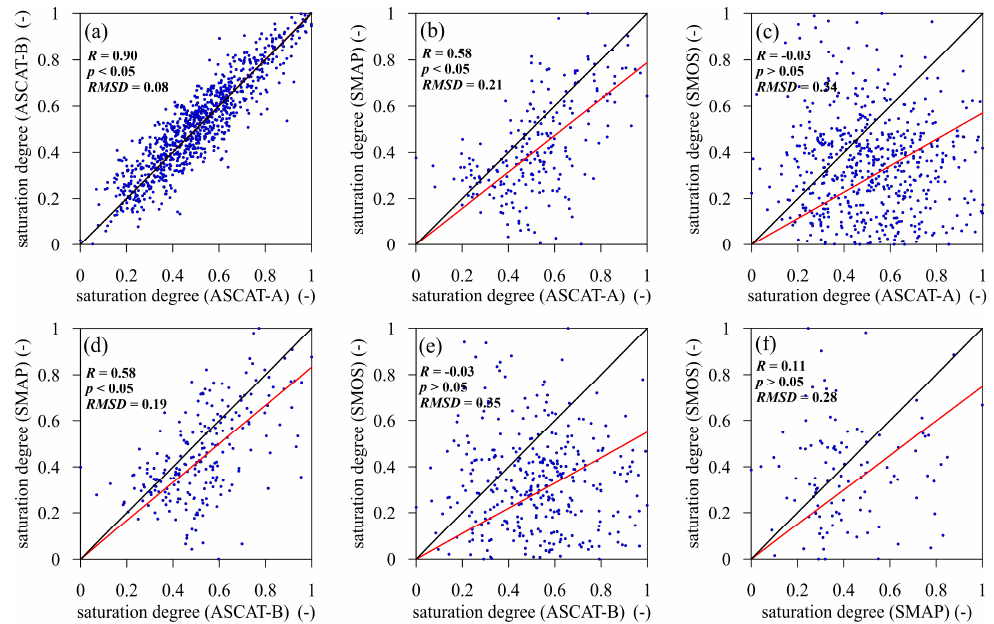
Figure 10. Correlations between catchment-averaged (cid:2033) (cid:3020)(cid:3020)(cid:3014)(cid:3019)(cid:3020) from different satellite products. ( a ) between ASCAT-A and ASCAT-B; ( b ) between ASCAT-A and SMAP; ( c ) between ASCAT-A and SMOS; ( d ) between ASCAT-B and SMAP; ( e ) between ASCAT-B and SMOS; ( f ) between SMAP